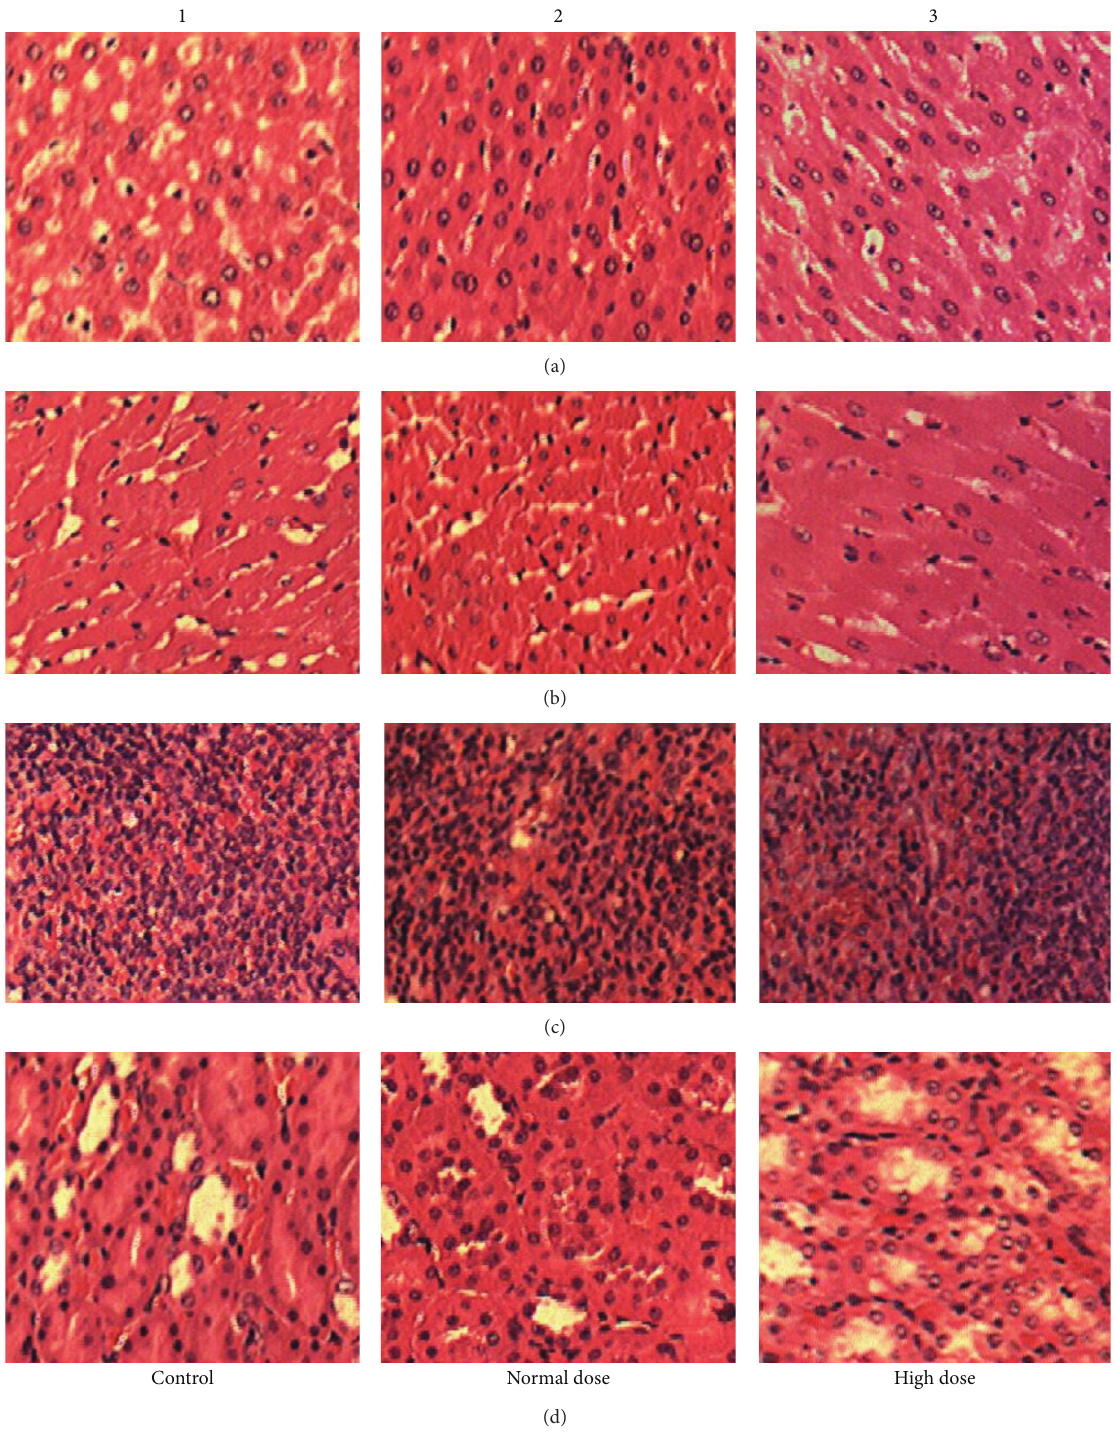
Figure2:Histopathologicanalysisincluded(a)liver,(b)heart,(c)spleen,and(d)kidneysectionsinmalerats.Photomicrographsoftransverse section of rats, column 1: control; column 2: normal dose; column 3: high dose multiple LAB strains (original magnification: ×